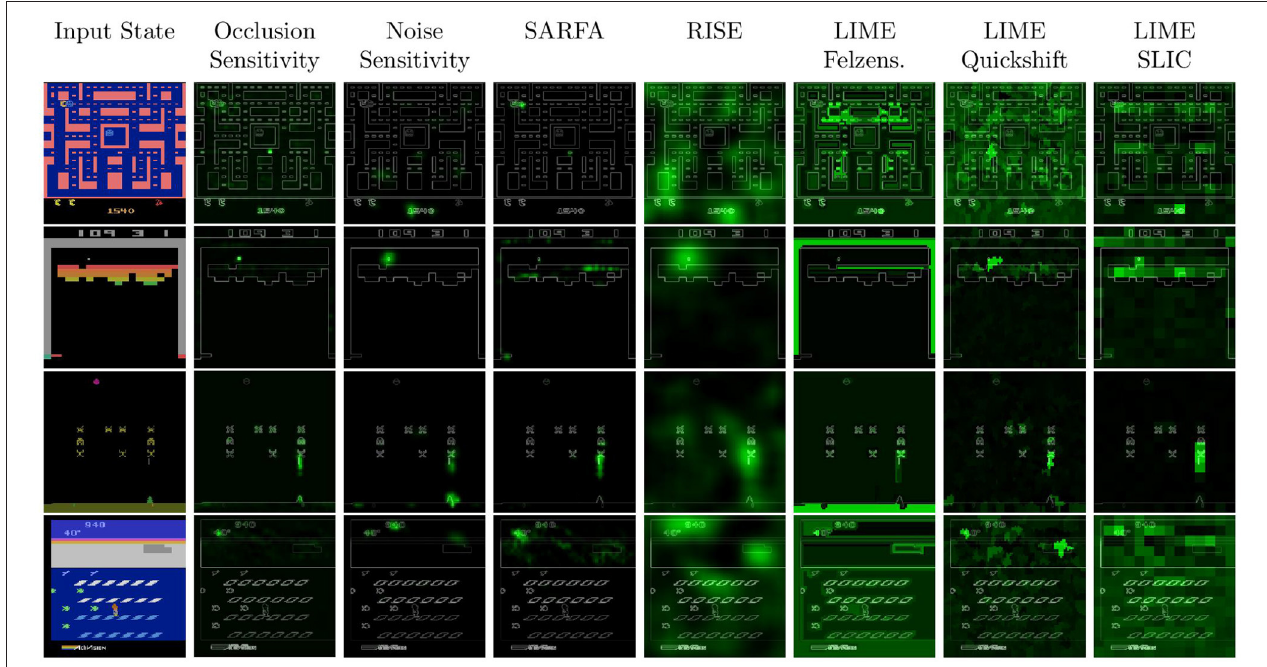
FIGURE 3 | Example saliency maps for games we tested. From top to bottom: Pac-Man, Breakout, Space Invaders, and Frostbite. For a better visibility, the saliency maps are displayed in green color over a simplified version of the states. The higher the intensity of the green color, the higher the relevance of the corresponding pixel for the agent’s